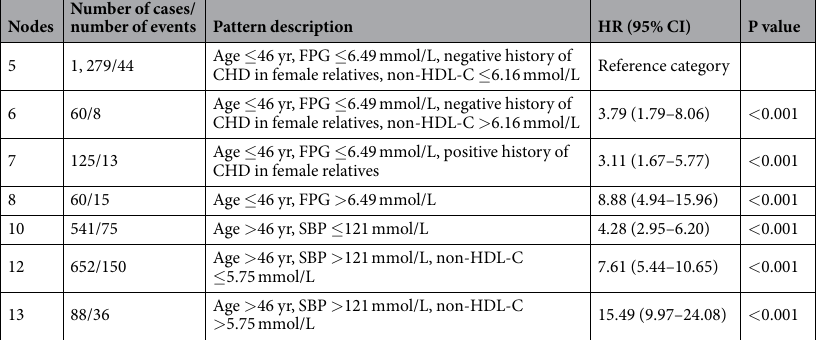
Table 2. Cox analyses of patterns identified using survival tree in the male population, Tehran Lipid and Glucose Study (1999–2012). Nodes : Terminal nodes number of survival tree for men; CI: Confidence intervals; CHD : Coronary heart disease; FPG : Fasting plasma glucose; HR : Hazard ratio; SBP : Systolic blood pressure.